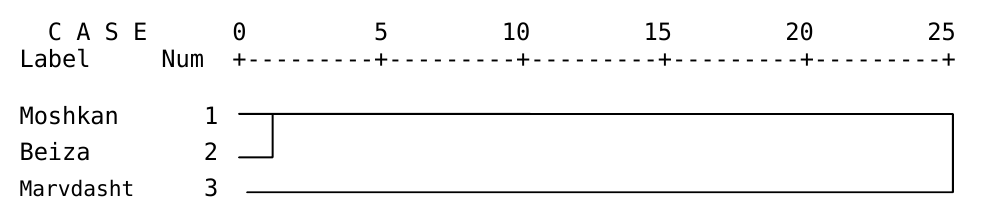
F IGURE 6. Cluster dendrogram using average linkage (between groups) for meristic and morphometric characters of Alburnoides qanati populations from the Kor River